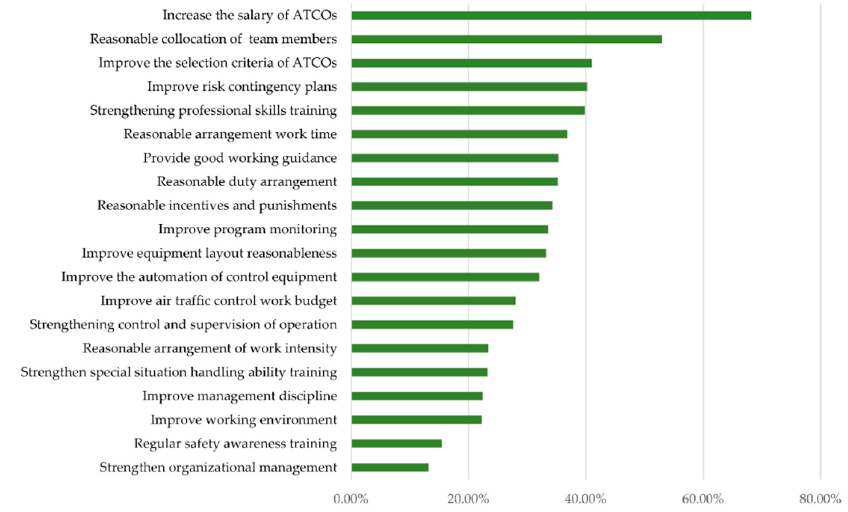
Figure 10. Countermeasure preferences by ATC professionals.